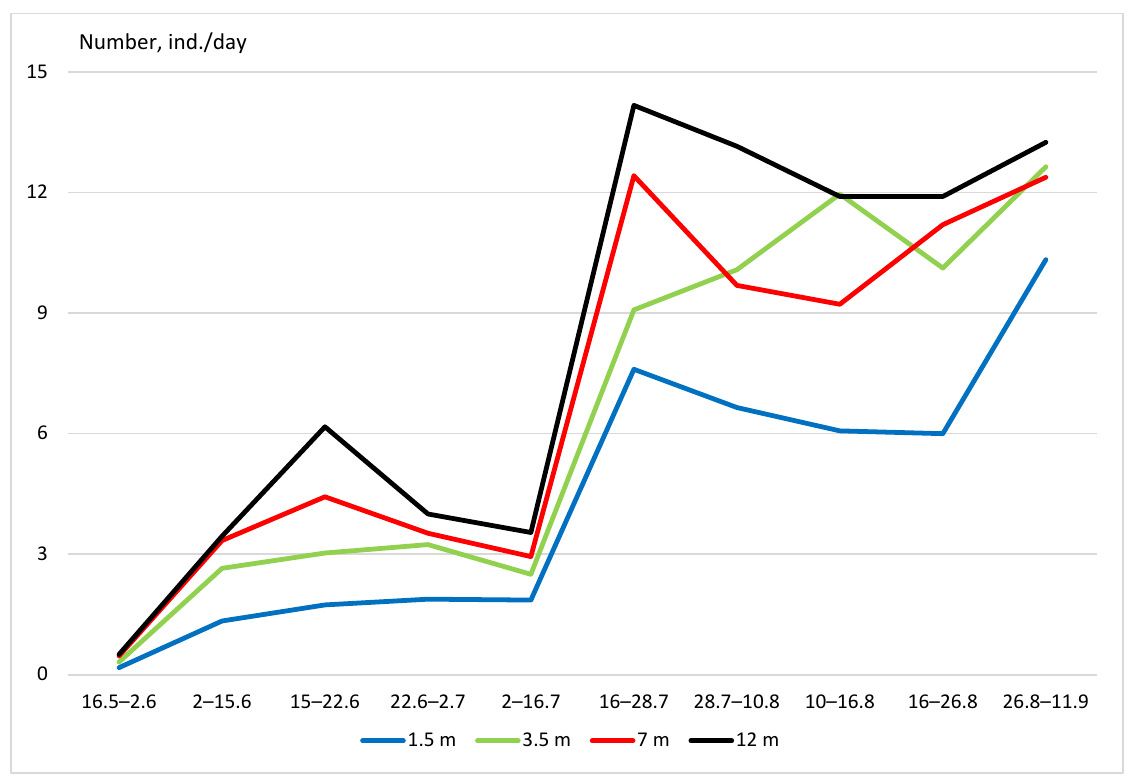
Figure 3. Seasonal dynamics of Lepidoptera abundance at various heights in deciduous forests.